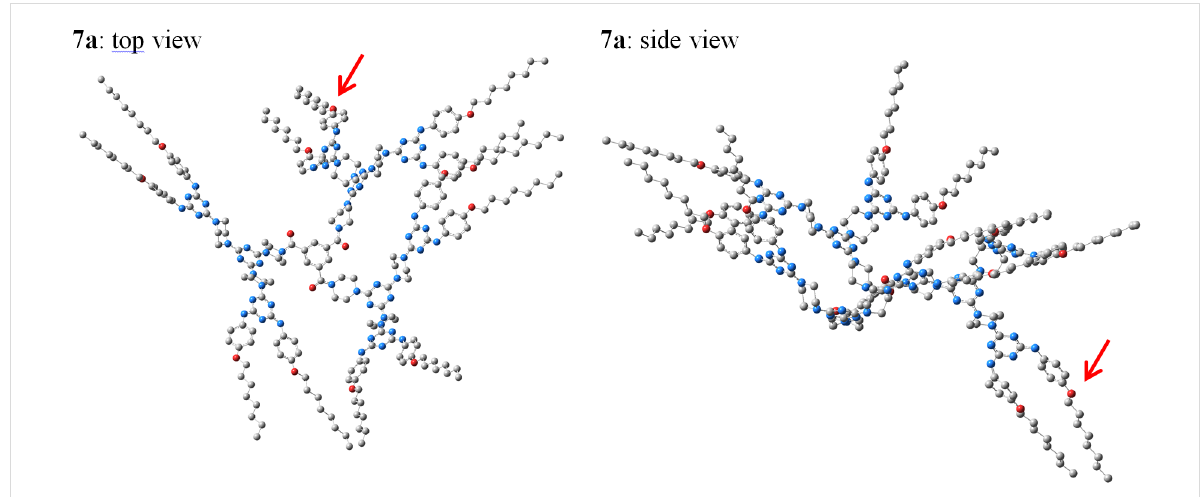
Figure 6: The DFT optimised geometry at M062X/def2-TZVP level of theory of G-2 dendrimer 7a in DMSO (hydrogen atoms were omitted for reasons of simplicity).